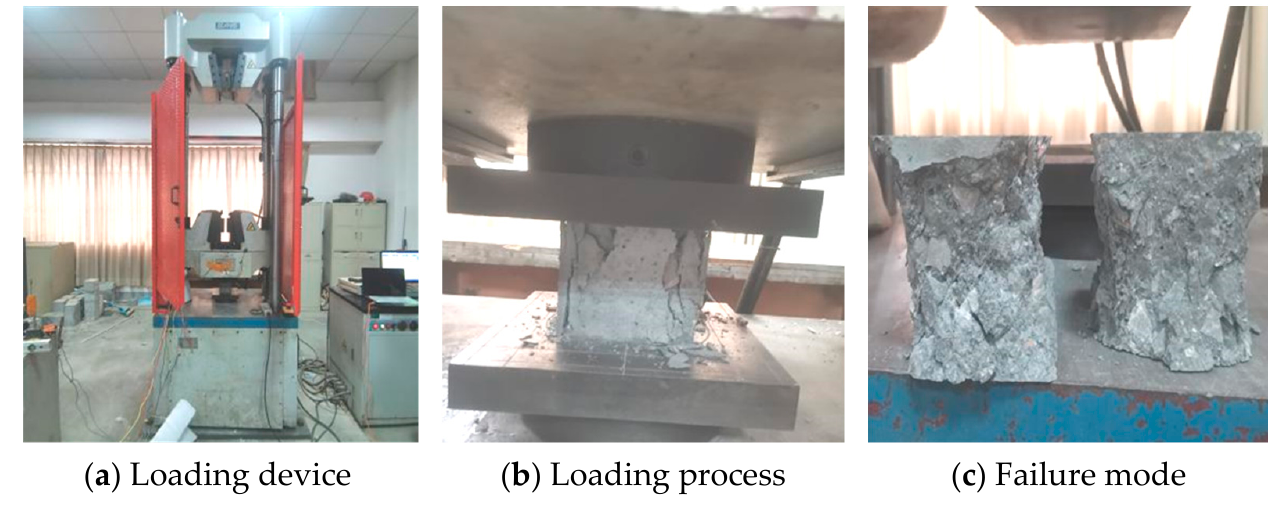
Figure 5. Schematic diagram of combined stirrup rebar (unit: mm).